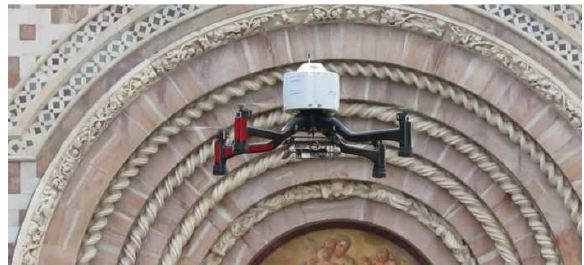
Figure 5. ANTEOS MINI during an acquisition